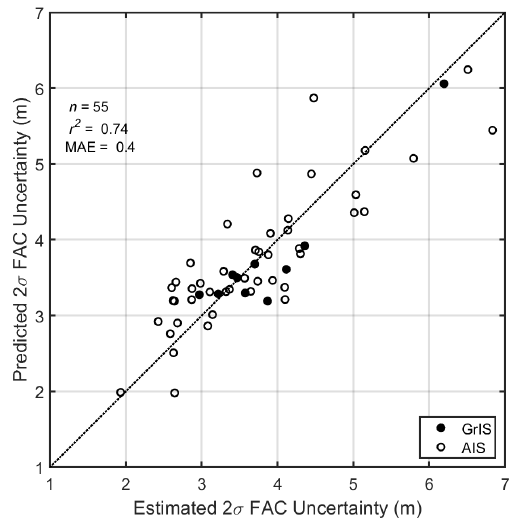
Figure 11. Boxplot of the mean absolute errors in density for stages (a) 1 and (b) 2 of densification in relation to the total melt experi- enced. The number of observations that make up each distribution is listed above each bar. The black rectangle represents the interquar- tile range of the mean absolute error, while the horizontal line within represents the median. The whiskers show the maximum and min- imum, with outliers shown as open circles. Melt fraction is defined as the ratio of mean annual melt to mean annual snow accumulation expressed as a percentage.